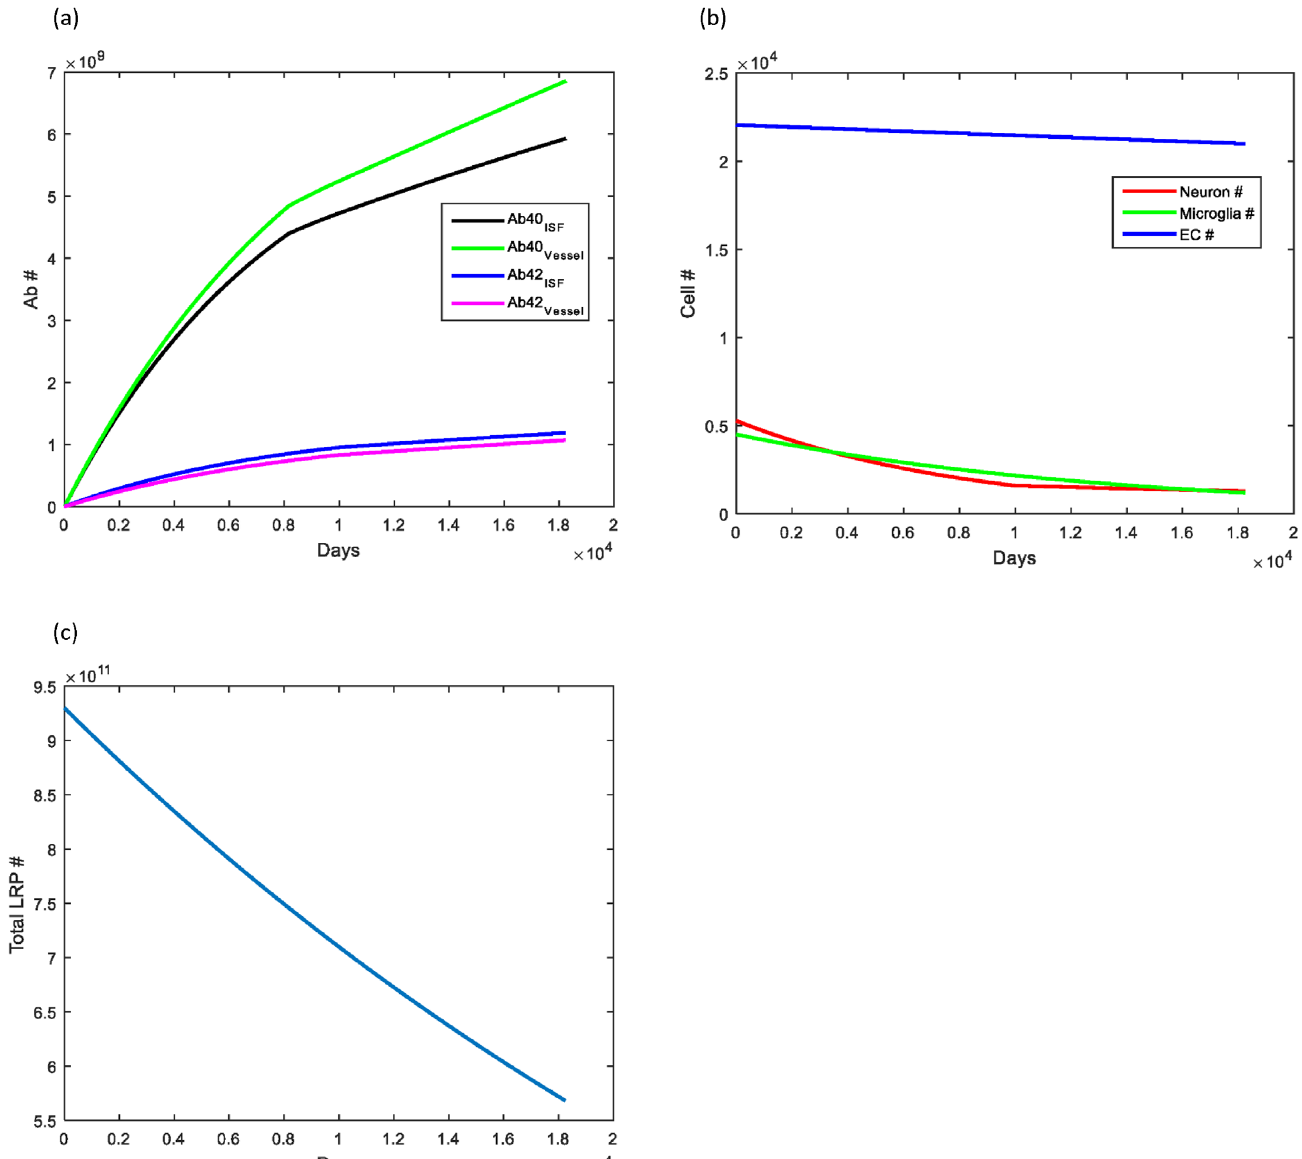
Fig 3. Simulation demonstrating effects of normal aging on A β levels within the brain parenchyma and local cerebral vessels. (A) Deposition of A β 40 occurred much more rapidly than that of A β 42 with approximately 6 times the amount of A β 40 deposited within cerebral vessels. This ratio agrees with what has been observed experimentally. The rate of A β increase started to decrease over the simulation as the number of neurons declined with aging and from elevations in the A β concentration. (B) The number of endothelial cells (blue) decreased slowly as they entered senescence. Microglia (green) decreased about 80% from their initial values, correlating with conversion to dystrophy. Neurons (red) also decreased secondary to natural loss as well as loss from elevated A β levels. (C) The total number of LRP-1 receptors decreased to approximately 60% of the initial value in accordance with the loss of brain endothelial